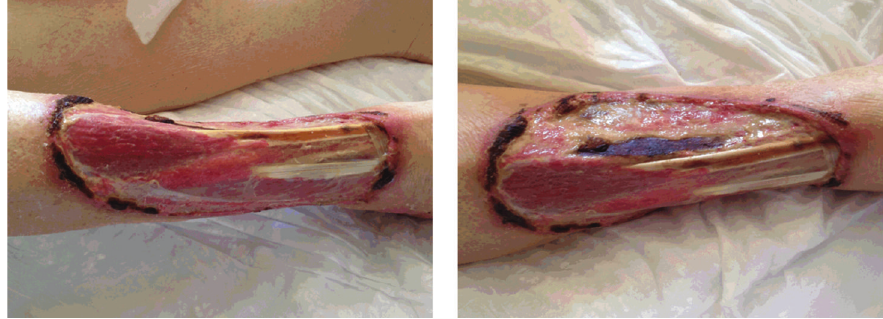
Figure 2: Surgical